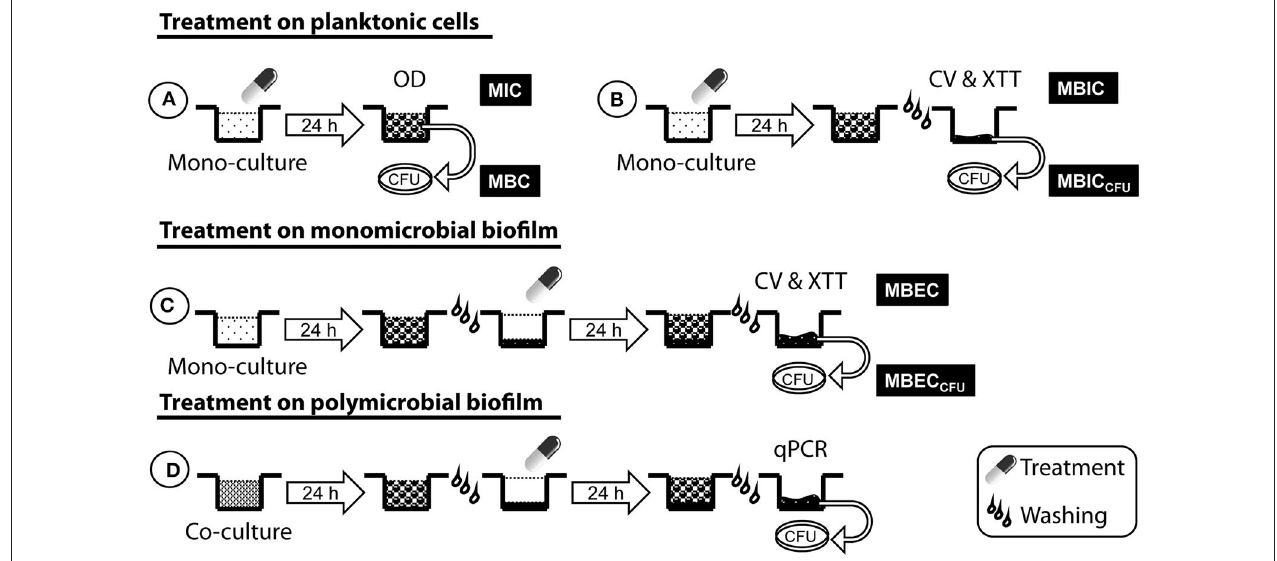
FIGURE 1 | Antimicrobial susceptibility testing of planktonic cells and biofilm forms. (A,B) Mono-cultures with conidia or bacteria were simultaneously inoculated with antimicrobial agents for 24h. Then, the optical density (OD) was measured to obtain the MIC (in planktonic cells), and the wells were washed before crystal violet (CV) and XTT analyses to determine the drug concentration that inhibited the biofilm formation (MBIC). (C,D) Mono- and co-cultures were incubated for 24h to obtain mature mono- and polymicrobial biofilms, and then treated with antimicrobial agents for another 24h. (C) CV and XTT analyses on monomicrobial biofilm enabled determining the drug concentration that eradicated the mature biofilm (MBEC). The viability of Sm following antibacterial treatment was assessed on planktonic cells (MBC), adherent cells of biofilm in formation (MBIC CFU ), and mature biofilm (MBEC CFU ). (D) Antimicrobial susceptibility of mono- and polymicrobial biofilms was compared using qPCR and viable plate count.